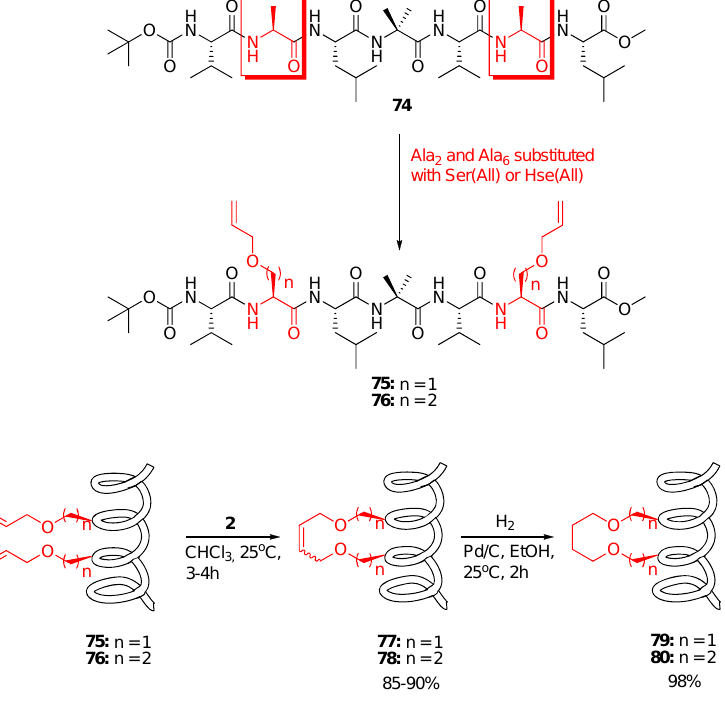
Figure 19. The first application of RCM to predominantly helical peptides.